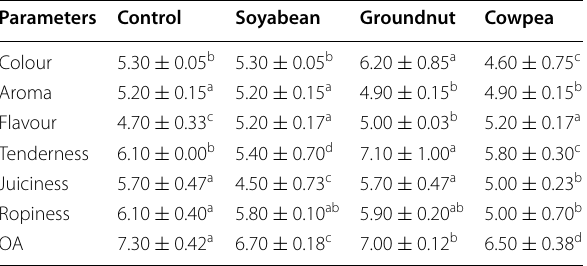
OA Overall Acceptability abcd Means in the same row with varying superscripts are significantly different ( P < 0.05)